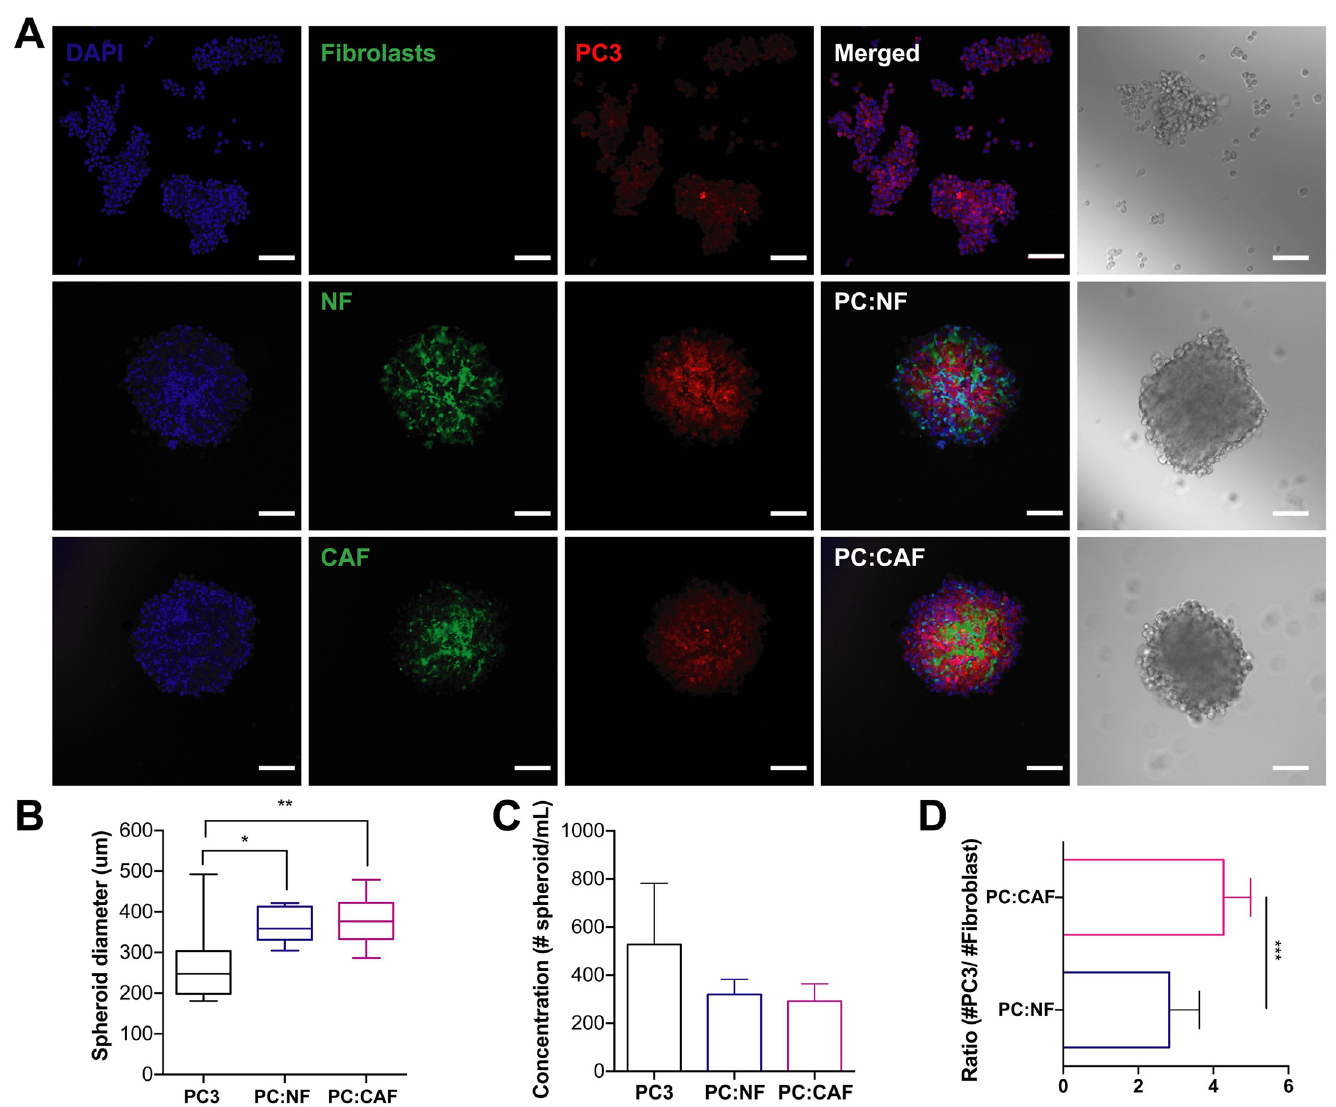
Fig 4. PC3 spheroids cocultured with prostate fibroblasts in AggreWell ™ 800 plates yielded consistent and reproducible spheroids. A . Brightfield image and confocal images of PC3 spheroids after 48 hr incubation. Scale bar = 100 μ m. B . Diameters of PC3, PC3-NF, and PC3-CAF spheroids. C . Concentration of spheroids/ mL in PC3, PC3-NF, and PC3-CAF cultures. D . Ratio of PC3 cells to fibroblasts in cocultured spheroids. The values represent the mean ± SD (n = 3). � p < 0.05, p < 0.01, ���� p < 0.0001.